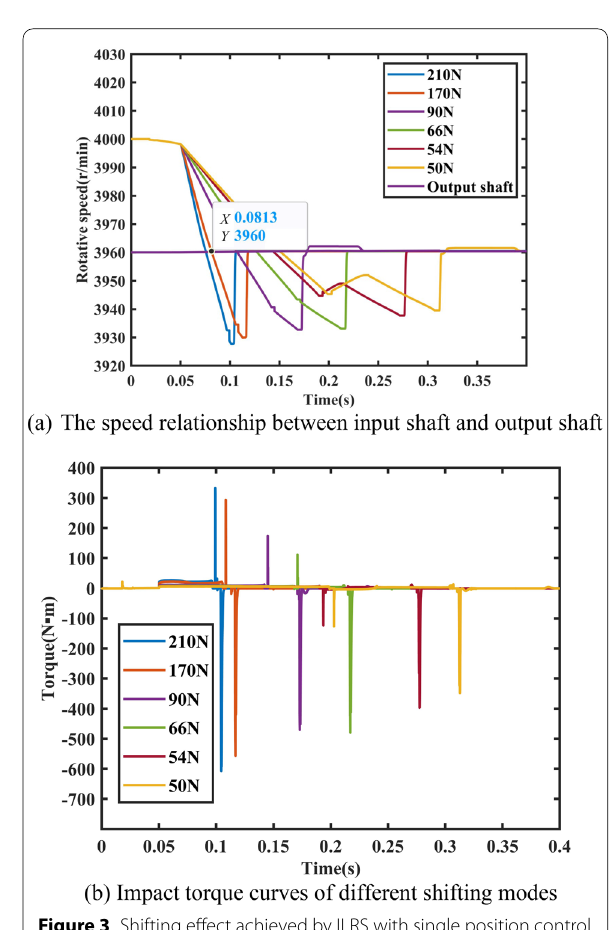
Figure 3 Shifting effect achieved by ILRS with single position